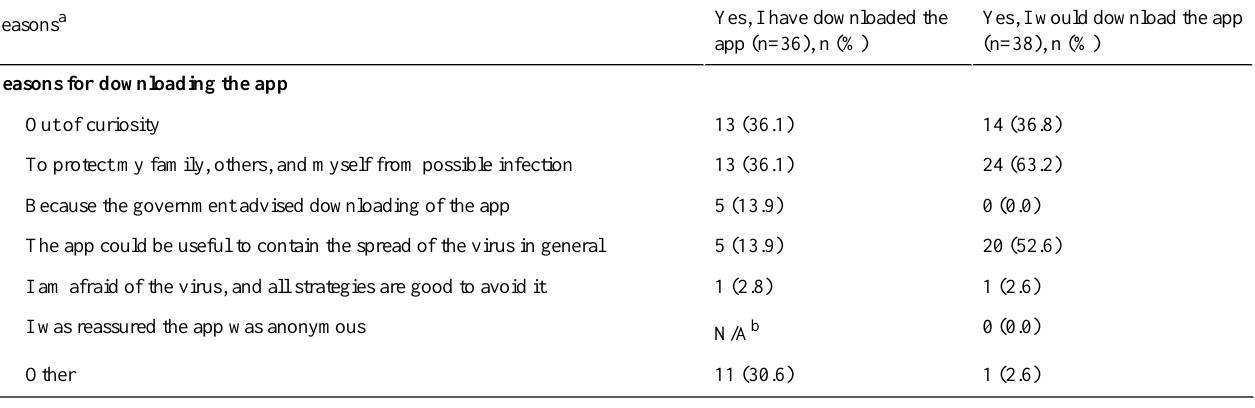
Table 2. Reasons for downloading the StopCovid app.